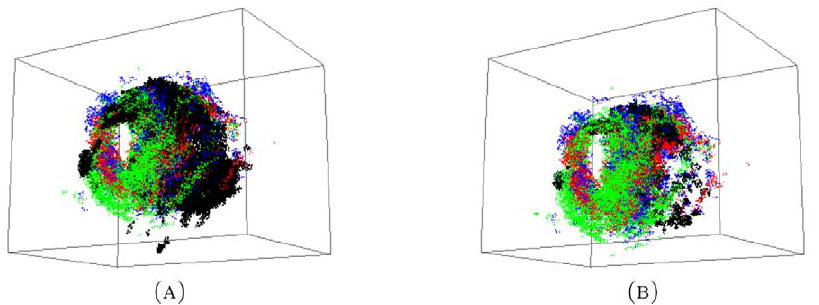
Figure 13. The data sets for (A) Combined(max); and (B) Combined(min). There are no persistent generators in either combined data set.